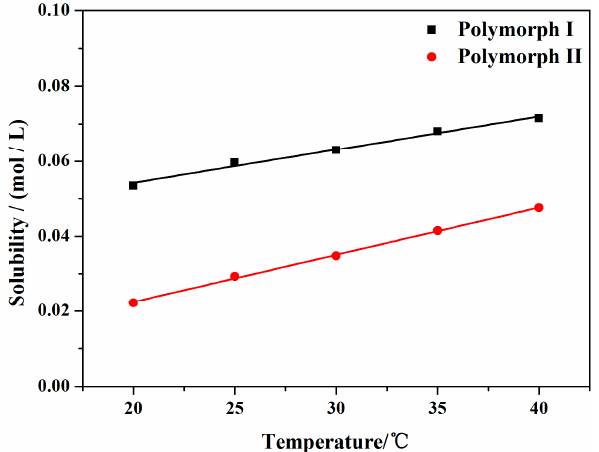
Figure 7. Solubility of polymorph I and polymorph II of theophylline in methanol.